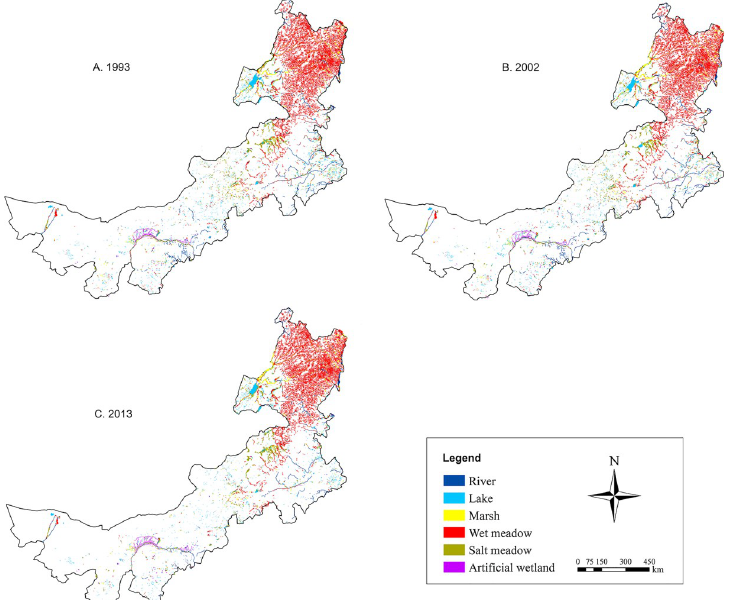
Fig 1. Spatial distribution of wetlands in Inner Mongolia for different stages.